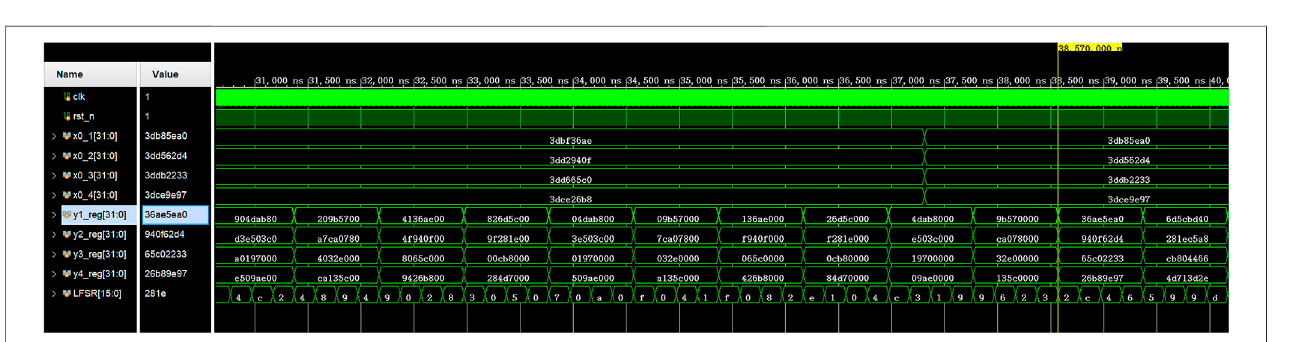
FIGURE 10 | Behavioral simulation results of the Hop fi eld neural network oscillator-based PRNG with feedback controller.